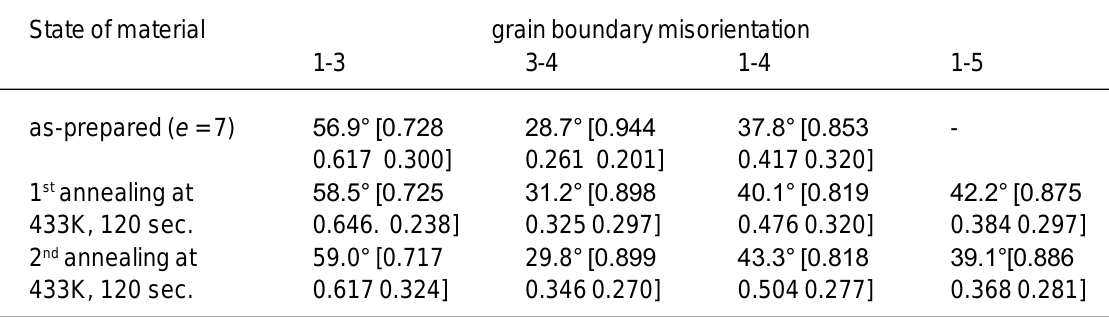
Table 1. Summary of the grain boundary misorientations measured in UFG aluminum alloy Al-4 %Cu-0.5 %Zr. The misorientation axis is shown in square parentheses.